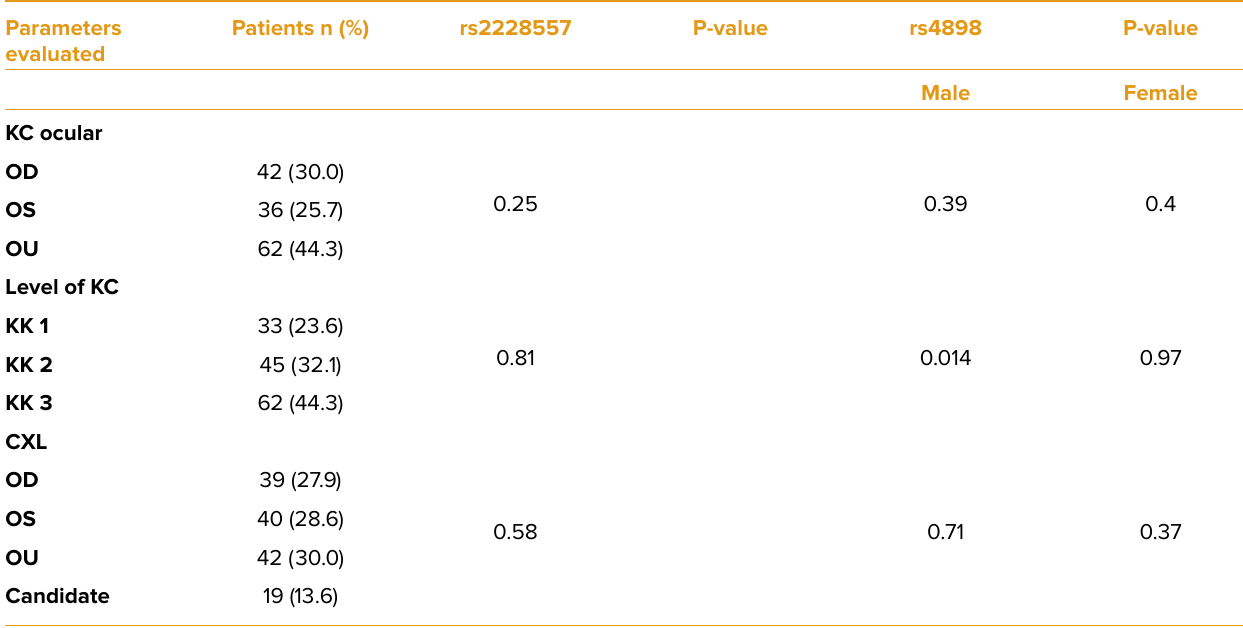
Table 3. Correlation of clinical and keratometric parameters with COL4A4 (rs2228557) and TIMP-1(rs4898) in keratoconus